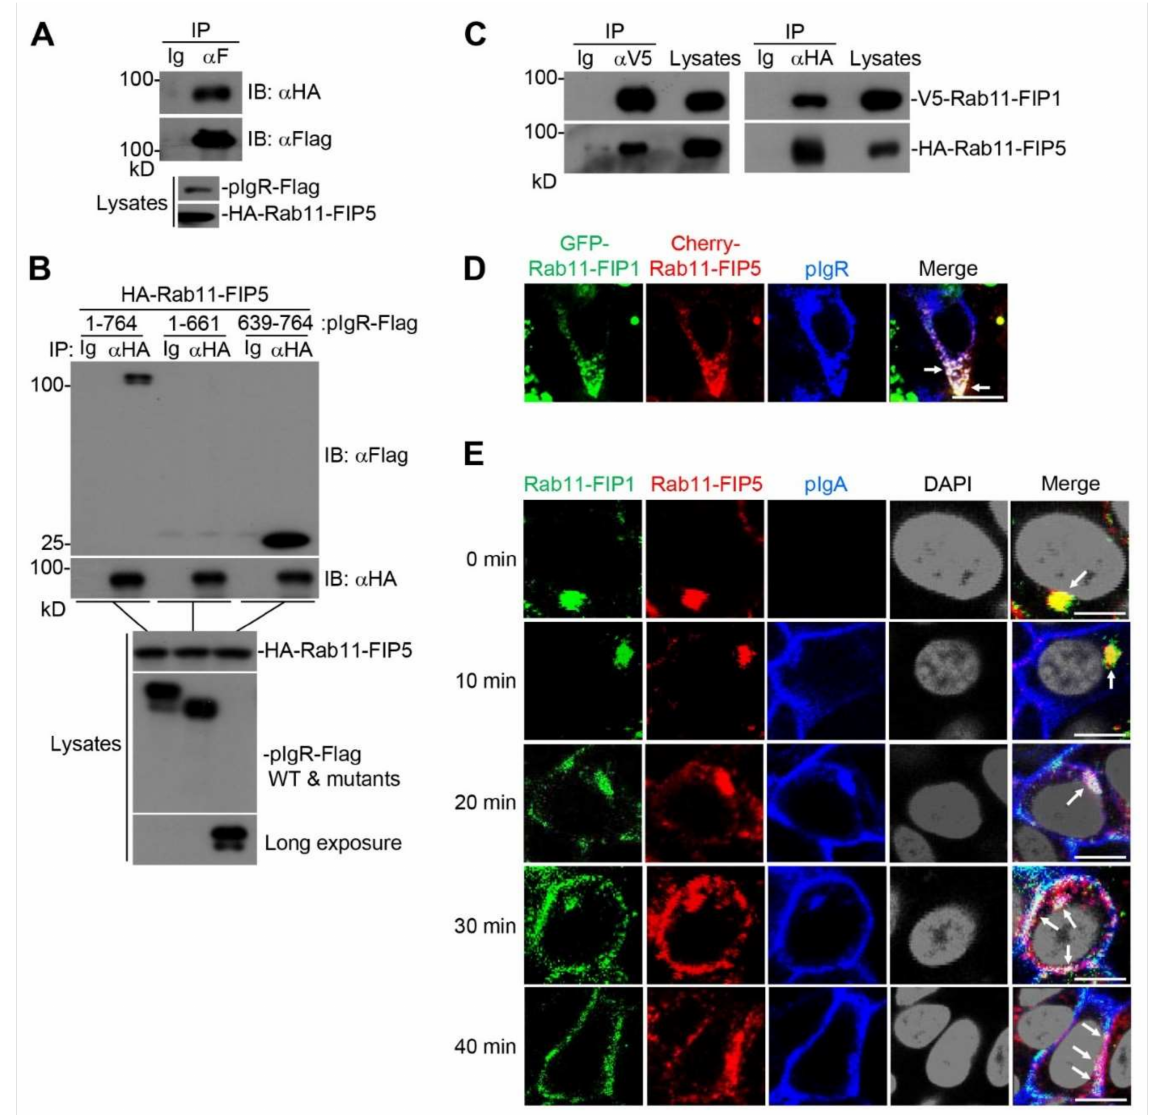
Figure 4. The Rab11 − FIP1, Rab11 − FIP5 and pIgR complex facilitates pIgA transcytosis. ( A ) The interaction between Rab11 − FIP5 and pIgR was detected. HEK293T cells (2 × 10 6 ) were co − transfected with the indicated plasmids for 24 h. Coimmunoprecipitation and immunoblot analyses were performed with the indicated antibodies. ( B ) Domain mapping of the interaction between Rab11 − FIP5 and pIgR. HEK293T cells (2 × 10 6 ) were co − transfected with the indicated plasmids for 24 h. Coimmunoprecipitation and immunoblot analysis were performed with the indicated antibodies. ( C ) The interaction between Rab11 − FIP1 and Rab11 − FIP5 was detected. HEK293T cells (2 × 10 6 ) were co − transfected with the indicated plasmids for 24 h. Coimmunoprecipitation and immunoblotting analyses were performed with the indicated antibodies. ( D ) Colocalization of Rab11 − FIP1, Rab11 − FIP5 and pIgR was detected. Vero − pIgR cells (1 × 10 5 ) were co − transfected with GFP − Rab11 − FIP1 (0.2 µ g) and Cherry − Rab11 − FIP5 (0.2 µ g) for 24 h. The transfected cells were fixed with 4% paraformaldehyde and stained with the indicated antibodies before observation by confocal microscopy. Scale bar: 10 µ m. ( E ) Colocalization of Rab11 − FIP1, Rab11 − FIP5 and pIgA was detected during pIgA transcytosis. Vero − pIgR cells (1 × 10 5 ) were grown on Transwell for 3 days. An amount of 20 µ g pIgA was added or not added to the basal chamber for 10 min at 37 ◦ C and cells were then washed for three times. Subsequently, cells were cultivated at 37 ◦ C and harvested at the indicated time points. Finally, the cells were fixed with 4% paraformaldehyde and stained with the indicated antibodies before observation by confocal microscopy. Scale bar: 10 µ m. Data of ( A – E ) are representative of three independent